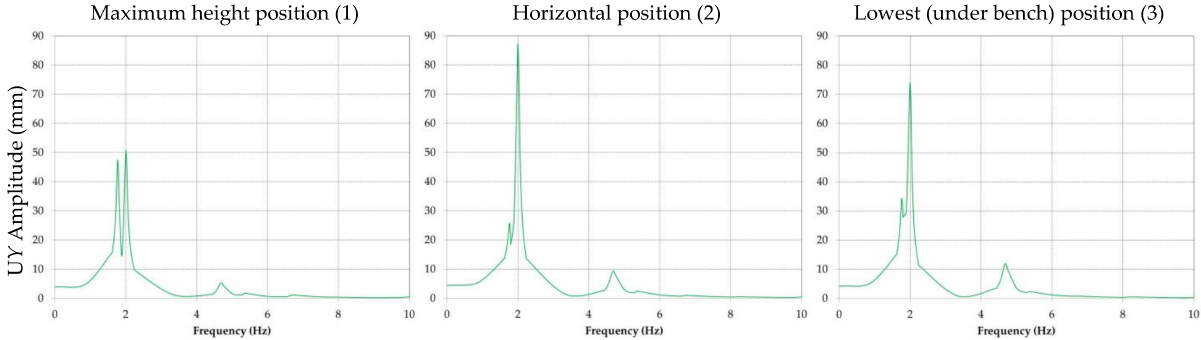
Figure 14. Comparative results of the amplitude of the displacement in direction Y for positions (1), (2), and (3) of the BWE boom.